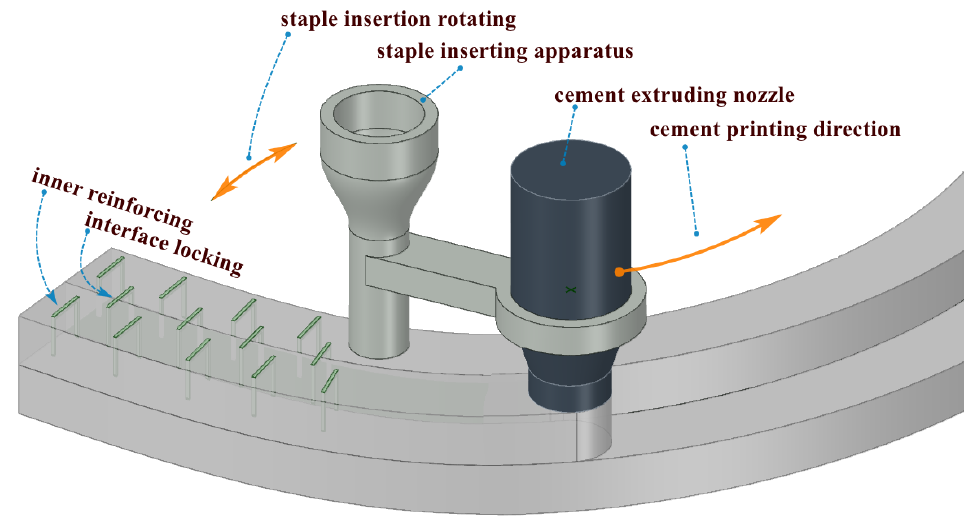
Figure 17. Illustration of the 3DCP-SIA system, reinforcing the extruded filaments.